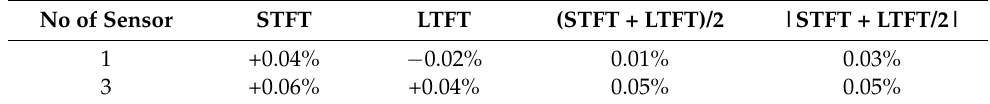
Table 2. Values of STFT and LTFT parameters registered for sensors 1 and 3. No of Sensor STFT LTFT (STFT + LTFT)/2 |STFT +